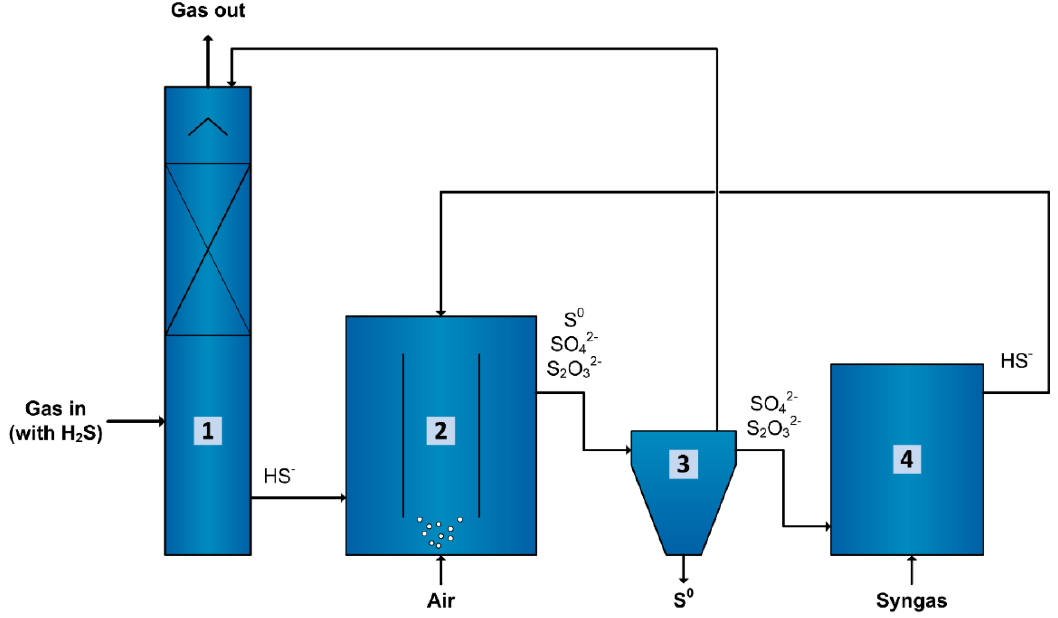
Figure 8. Biological process for gas desulfurization using an anaerobic sulfate/thiosulfate reducing bioreactor to enable bleed stream recycling. The sulfide (H 2 S) present in the gas is dissolved in an alkaline solution as HS − using a scrubber (1). This HS − rich solution goes to an aerobic bioreactor (2) where it is biologically oxidized under controlled microaerophilic conditions to mostly elemental sulfur (S 0 ) and a minor fraction to sulfate (SO 42 − ) followed by chemical oxidation via polysulfides, to thiosulfate (S 2 O 32 − ). The S 0 is separated in a settler (3) and most of the liquid is recycled to the scrubber (1). Part of the liquid from the settler (3) goes to an anaerobic bioreactor (4) where SO 42 − and S 2 O 32 − are reduced to HS − using syngas as an electron donor. The HS − produced is recycled back to the aerobic bioreactor (2). With time, this prevents accumulation of SO 42 − and S 2 O 32 − in the whole system and theoretically reduces the amount of caustic required to increase the pH to almost zero. Additionally, it will prevent the disposal of bleed stream into the environment and maximize the S 0 production.